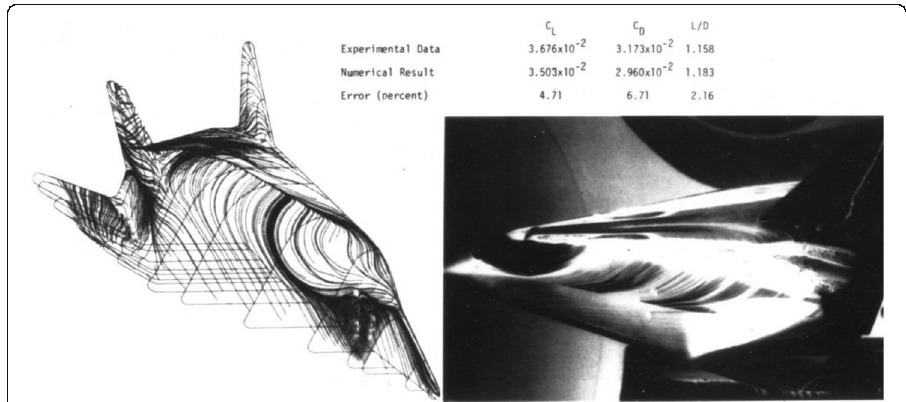
Fig. 8 Comparison of computational and experimental observation of X-24c reentry